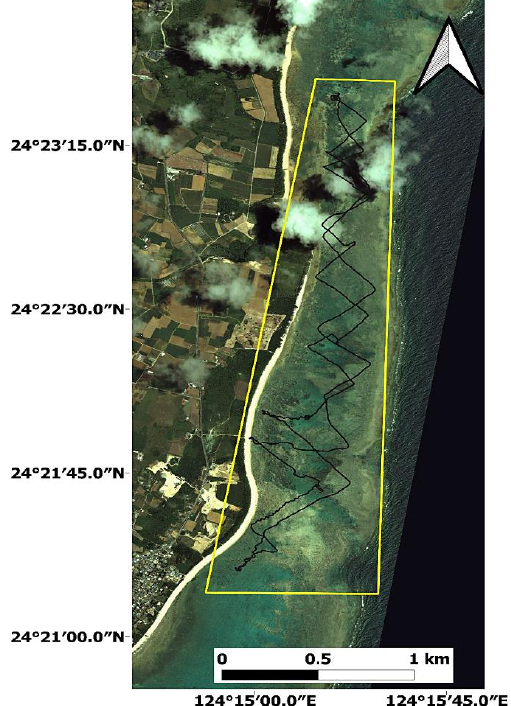
Figure 1. The field survey path over the study area of Shiraho, Ishigaki Island, Japan (Quickbird satellite image).